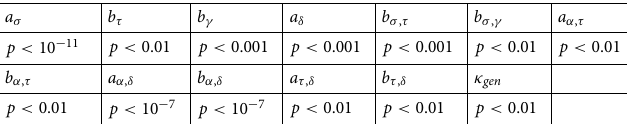
Table 2. Significant MsCr measures in DOC.